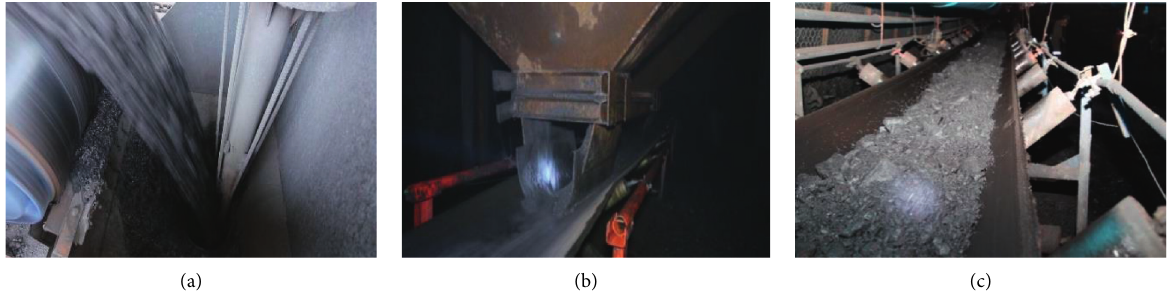
Figure 4: Gangue transportation system. (a) Gangue delivery. (b) Buffer silo. (c) Conveyor belt.